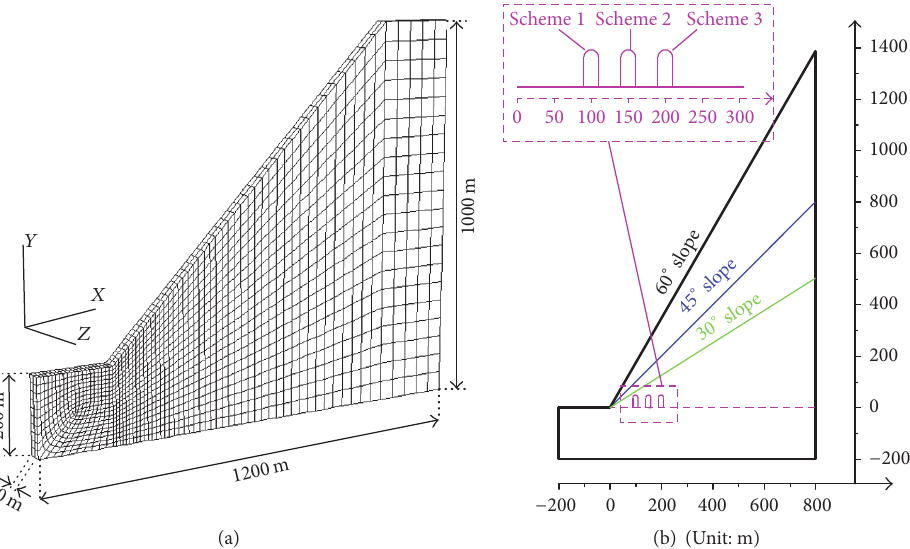
Figure 1: A numerical model and three schemes: (a) a slope angle of 45 ∘ ; (b) three schemes to locate an underground cavern under different slope angles.